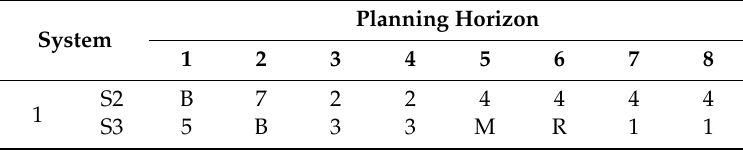
Table 2. Production planning for the flexible manufacturing system.